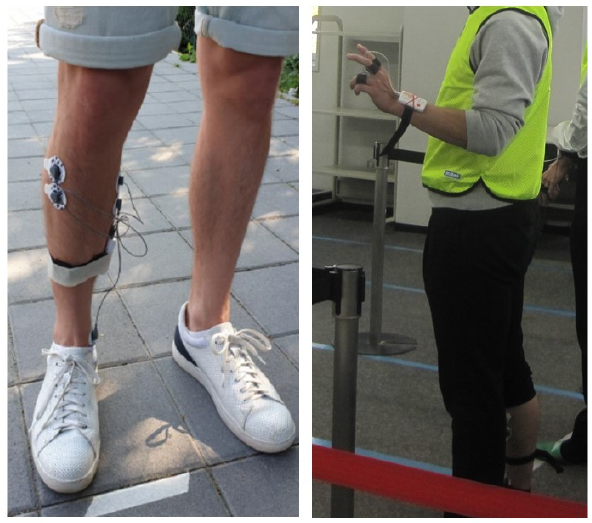
Figure 3. Wearable devices adopted.